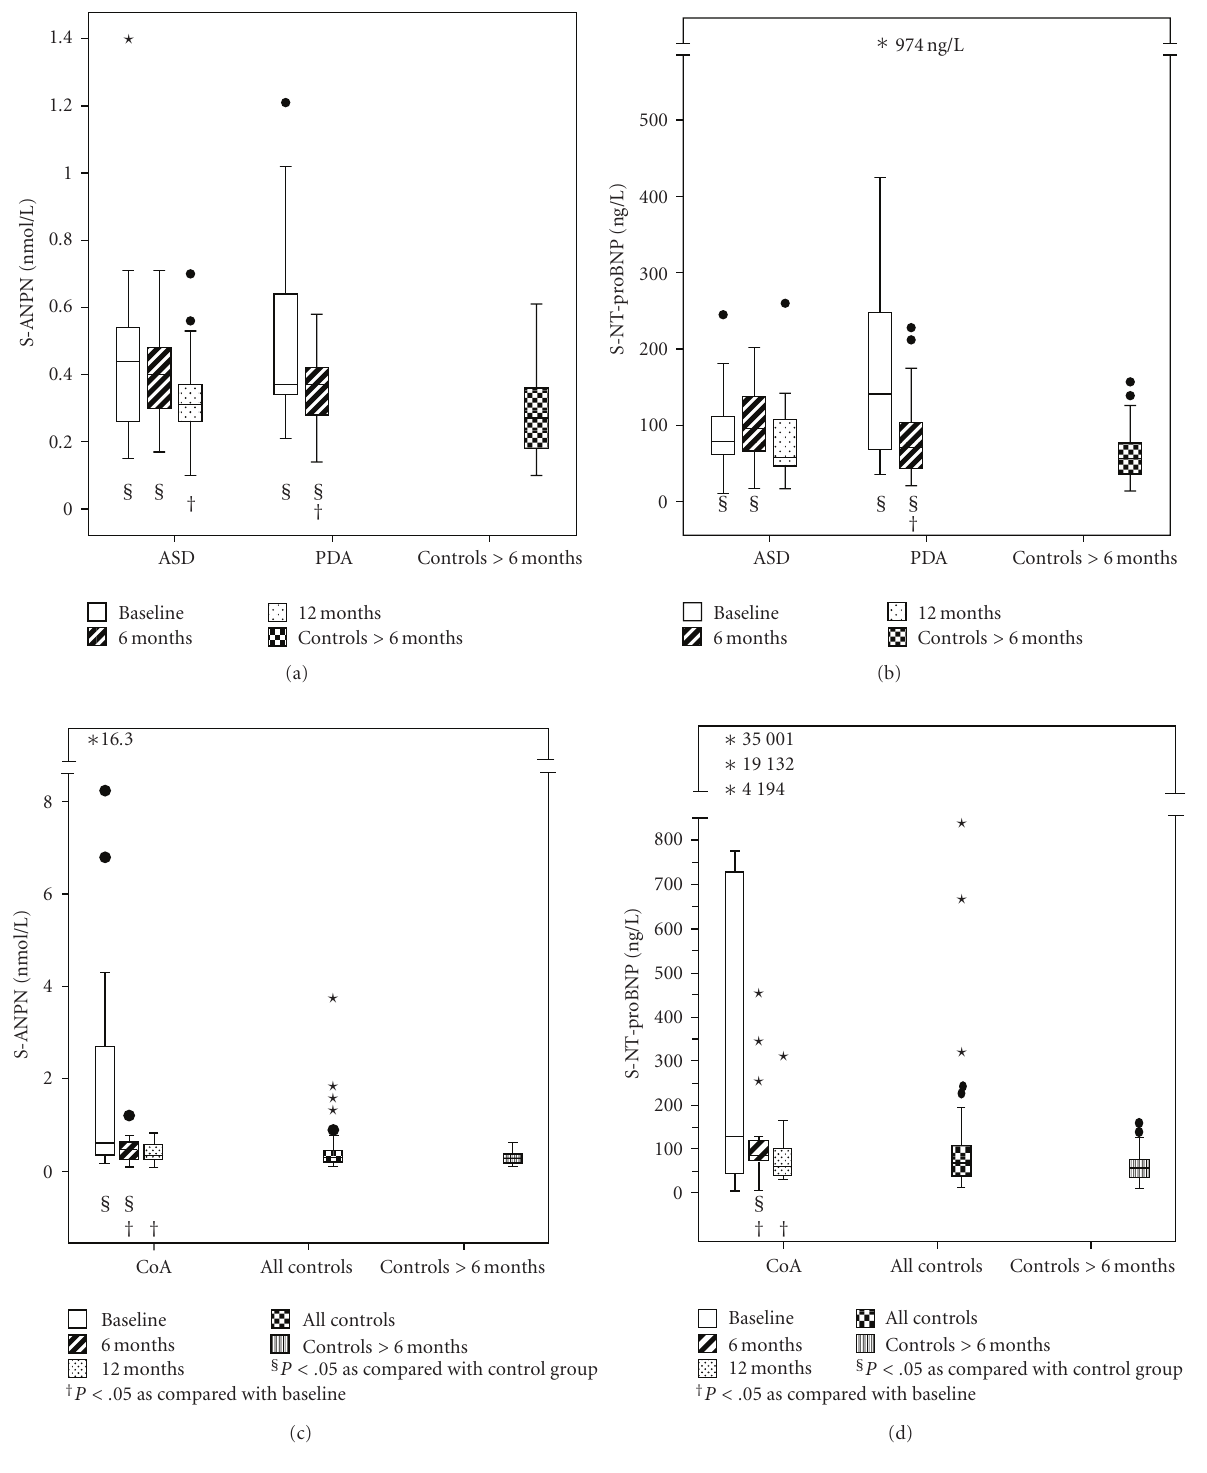
Figure 1: Serum levels of (a) N-terminal proatriopeptide (ANPN) and (b) N-terminal probrain natriuretic peptide (NT-proBNP) in patients with atrial septal defect (ASD) and patent ductus arteriosus (PDA) measured at baseline and at 6 and 12 months’ follow-up, and in controls older than six months. Serum levels of (c) N-terminal proatriopeptide (ANPN) and (d) N-terminal probrain natriuretic peptide (NT- proBNP) in patients with coarctation of the aorta measured at baseline and at 6 and 12 months’ follow-up, and in all controls and controls older than six months. Whiskers at the top and bottom of each box indicate maximum and minimum; the top and bottom of each box the third and first quartiles; line through the box the median. Solid circles are outliers and ∗ indicates an extreme